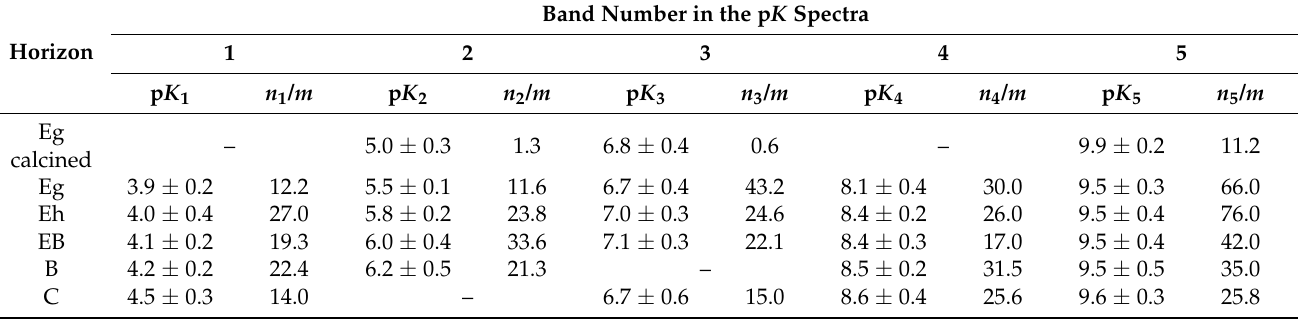
Table 6. The values of the p K i groups (above the line) of Eutric Albic Stagnic Retisol (Loamic) and the number of groupings ( n i / m , mmol · kg − 1 ) corresponding to them (below the line). Band Number in the p K Horizon